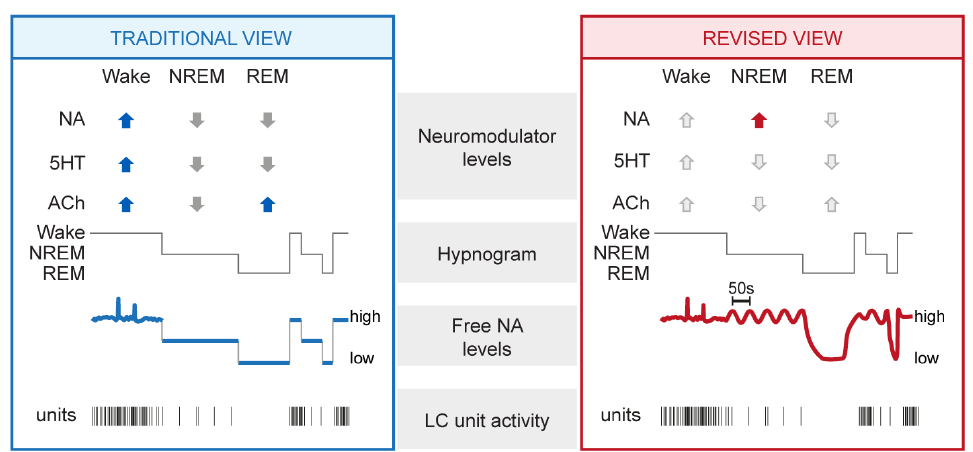
Figure 1. Summary of traditional and revised views on the neuromodulatory profiles of wakefulness and sleep, with a focus on noradrenergic signaling. Traditional ( left ) and revised ( right ) views derived from animal experimentation are summarized and complemented with data-derived schematic represen- tations of NA dynamics and LC unit activity. From top to bottom: mean levels of major neuromodulators (blue up and gray down arrows symbolize high and low levels in the traditional view), a representative hypnogram of mouse sleep–wake behavior, free NA levels, and representative discharges of a LC unit. Novel insights central to the revised view are highlighted with the red arrow, whereas unaltered neuromodulatory levels are shown with light grey arrows. NA, noradrenaline; 5HT, serotonin; ACh, acetylcholine; NREM, NREM sleep; REM, REM